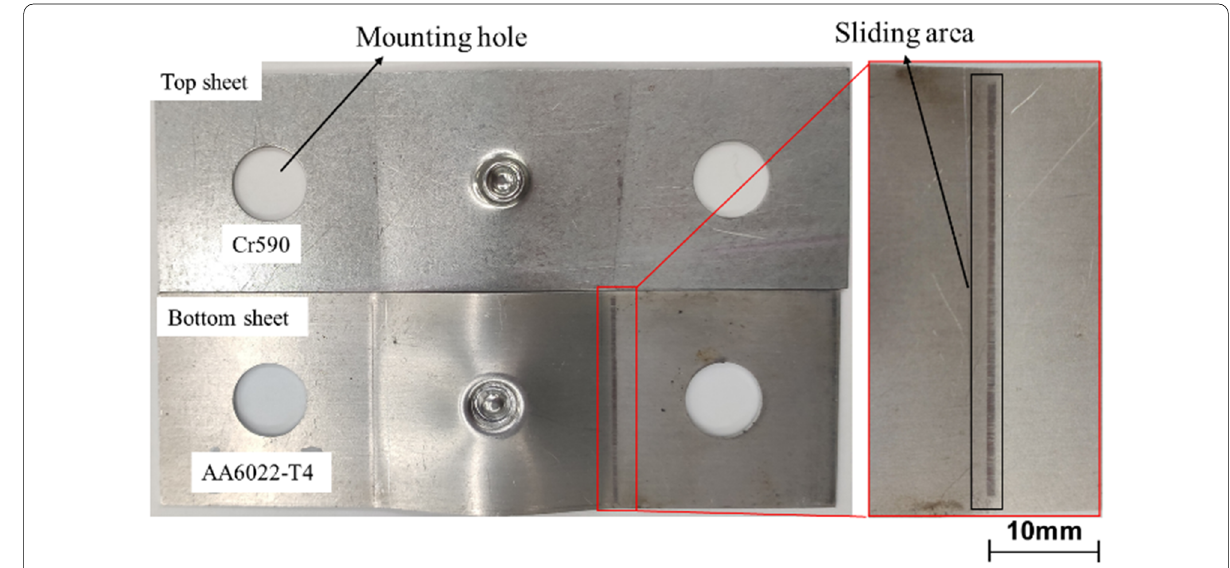
Figure 9 Failure mode of SPR-B joint in cross-section